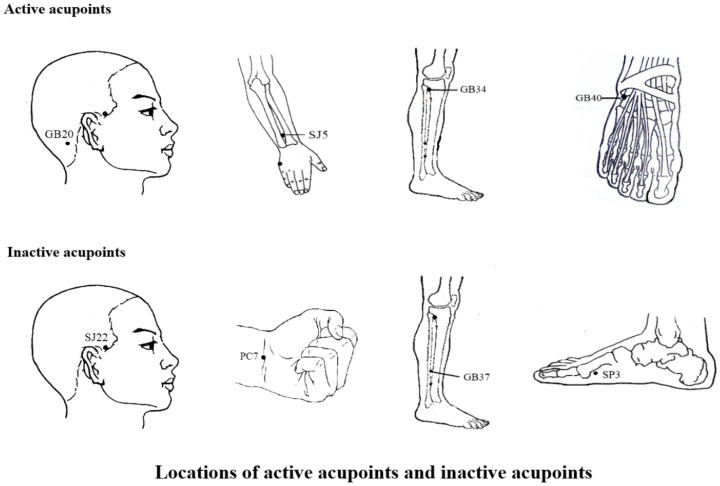
Locations of active acupoints and inactive acupoints.The active acupoints were located as follows: SJ5, on the dorsal aspect of the forearm on the line connecting SJ4 and the tip of the elbow, 2 cun above the transverse crease of the wrist between the ulna and radius; GB20, in a depression between the upper portion of the sternocleidomastoid muscle and the trapezius; GB34, on the lateral aspect of the lower leg in the depression anterior and inferior to the head of the fibula; GB40, anterior and inferior to the external malleolus in a depression on the lateral side of the tendon of the extensor digitorum longus. The inactive acupoints were located as follows: SJ22, on the side of the head on the posterior border of the hairline of the temple at the level with the root of the auricle, posterior to the superficial temporal artery; PC7, in the middle of the transverse crease of the wrist between the tendons of the palmaris longus and flexor carpi radialis; GB37, on the lateral aspect of the lower leg 5 cun above the tip of the external malleolus on the anterior border of the fibula; SP3, proximal and inferior to the head of the 1st metatarsal-phalangeal joint in a depression at the junction of the red and white skin.